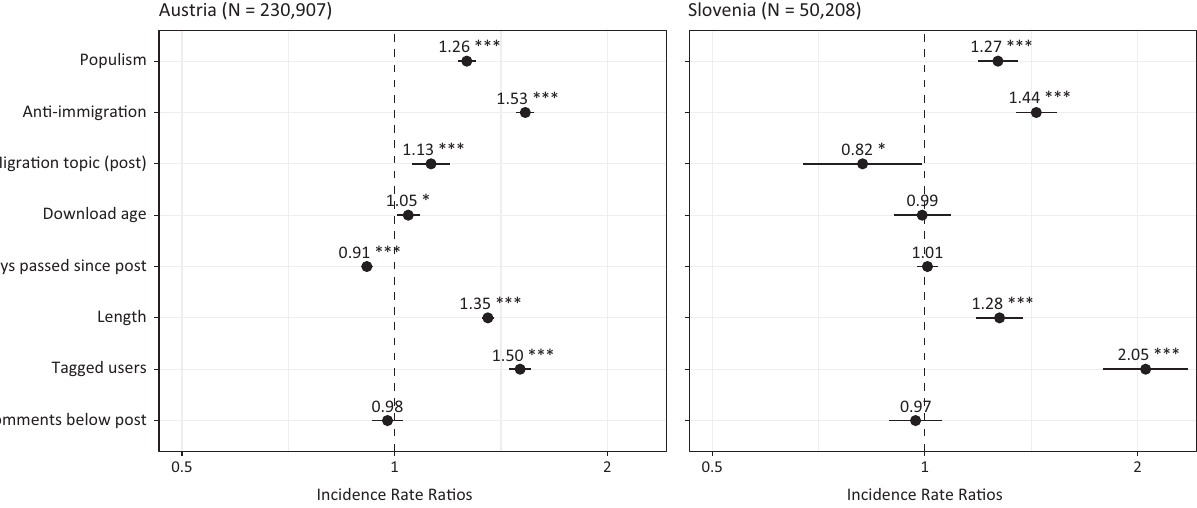
Figure 1. Incidence rate ratios from Model 1 (Austria) and Model 2 (Slovenia) from multilevel negative binomial regressions on the number of replies per comment for each country. Note: Varying intercepts on post and account